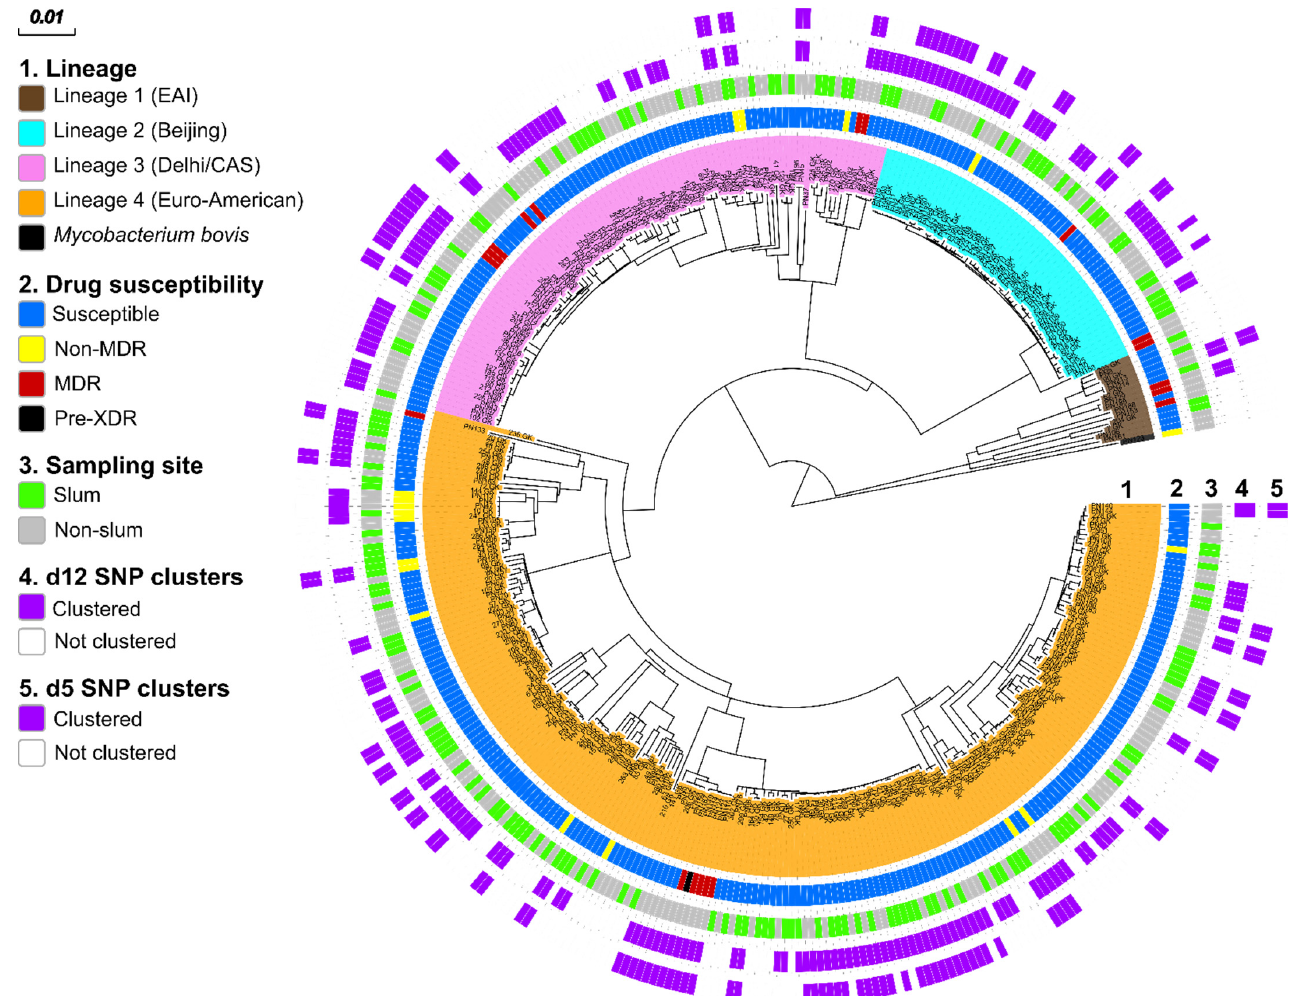
Figure 2. MTBC population structure in urban and slum areas of Nairobi, Kenya. Maximum likeli- hood tree based on 18,167 concatenated single-nucleotide polymorphisms (SNPs) using a general time-reversible substitution model. Colored bars code for (inner to outer ring) M. bovis and MTBC lineages (L1–4); genotypic DST results stratified to MDR, non-MDR, and fully susceptible; sampling location; and clustered and non-clustered strains (SNP distance ≤ 12 and ≤ 5). DST = drug suscepti- bility testing, MDR = multidrug-resistant (simultaneous resistance towards isoniazid and rifam- picin); Pre-XDR= pre-extensively drug-resistant (an MDR which is also resistant to any fluoroquin- olone), MTBC = Mycobacterium tuberculosis complex.